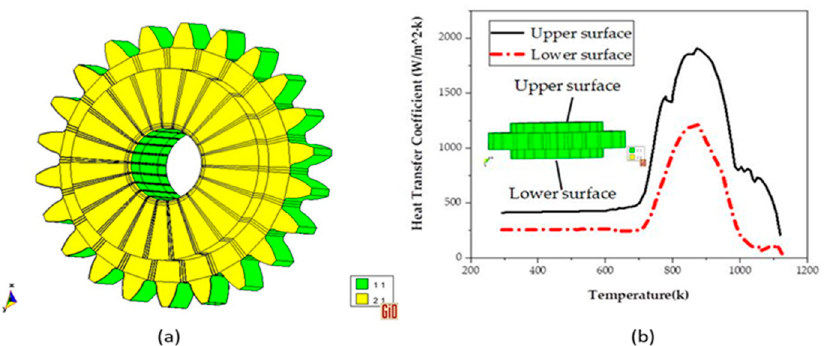
Figure 10. Heat transfer boundary condition and heat transfer coefficients . ( a ) Boundary surface (The green color is the upper end face, and the yellow color is the lower end face). ( b ) Heat transfer coefficients [18].